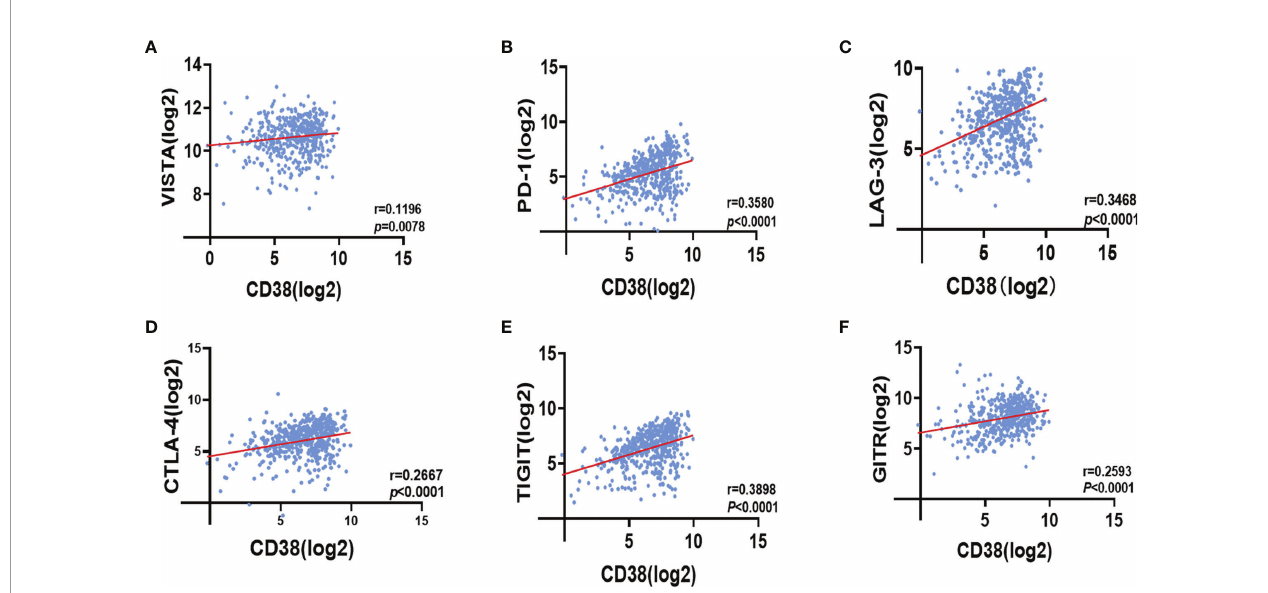
FIGURE 5 | Correlation between CD38 expression and VISTA (A) , PD-1 (B) , LAG-3 (C) , CTLA-4 (D) , TIGIT (E) as well as GITR (F) in HNSCC with cBioportal